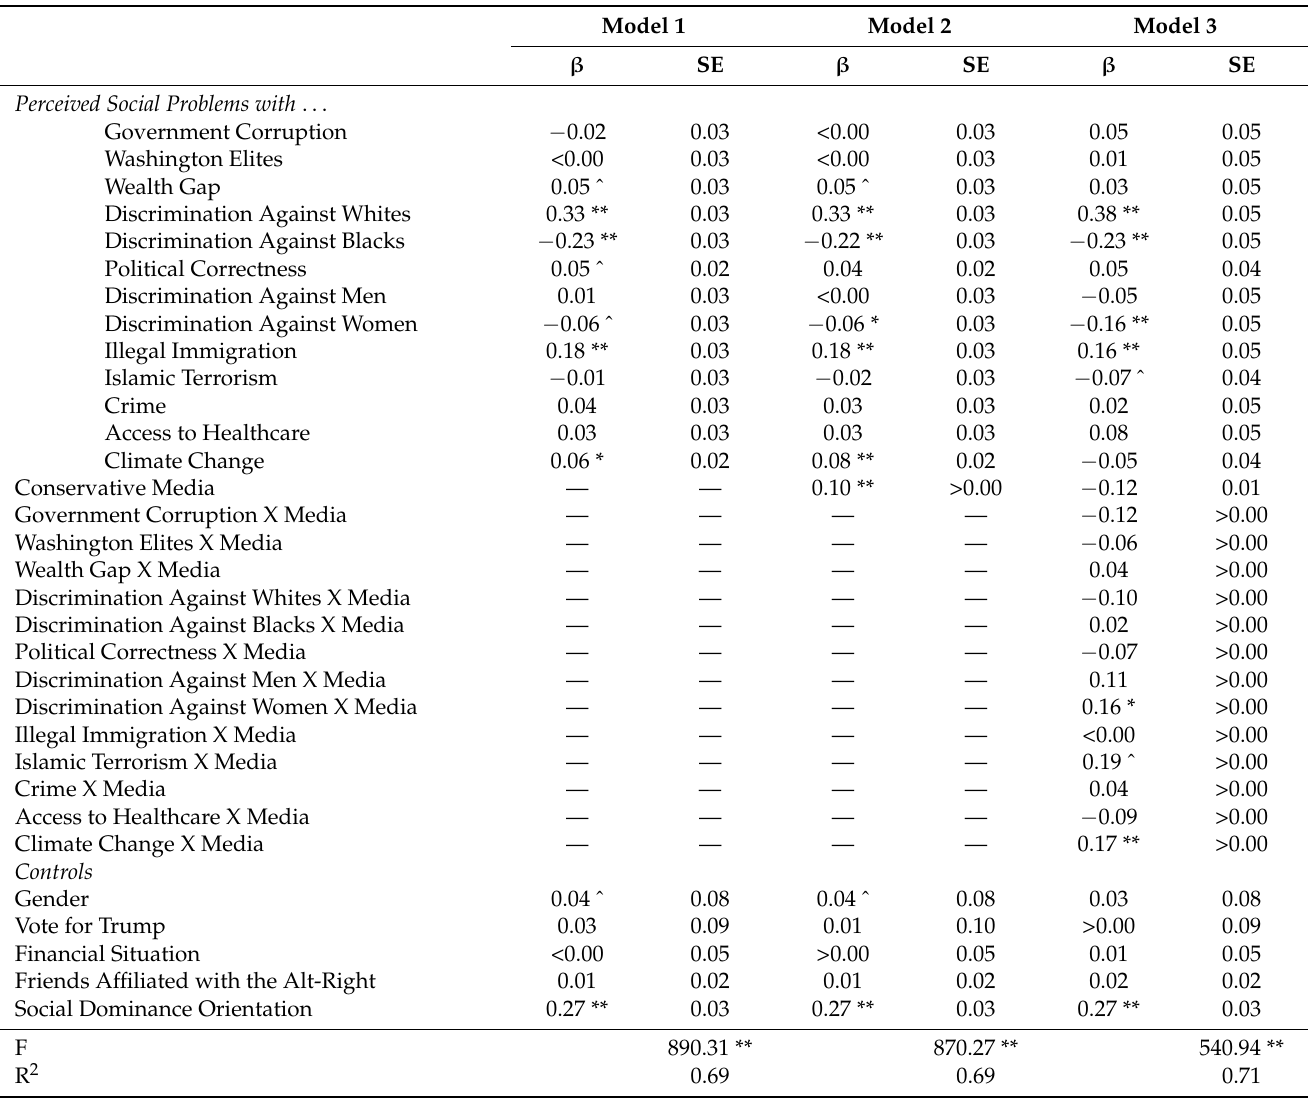
Table 2. OLS Regression of Perceptions of Social Issues on Status